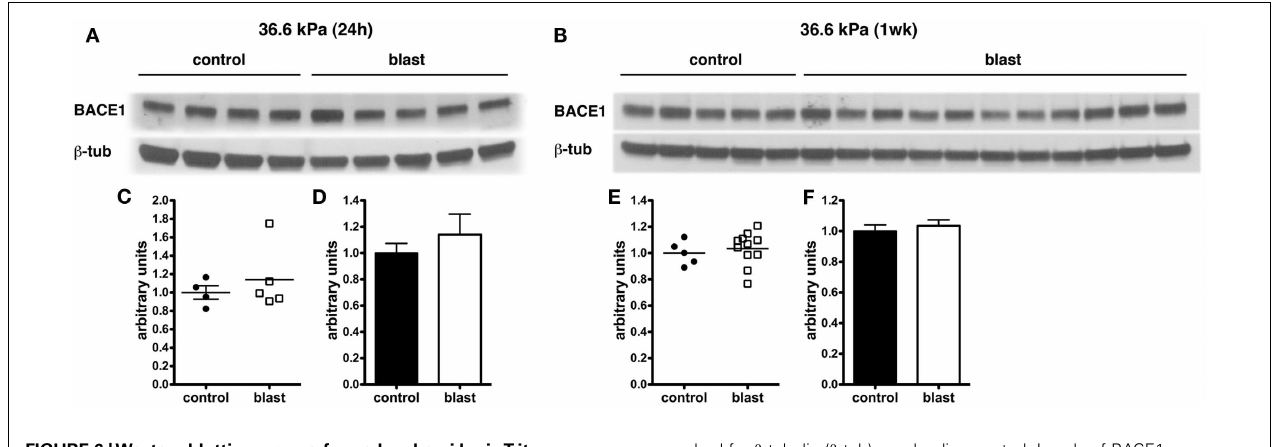
FIGURE 6 |Western blotting was performed on hemi brainTriton X-100 extracts from sham exposed (controls) or rats exposed to 36.6kPa blast injury harvested at 24h (A) or 1week post-blast exposure (B). The top panel in each set shows blotting with an antibody that recognizes BACE1. In the lower panels the blots were